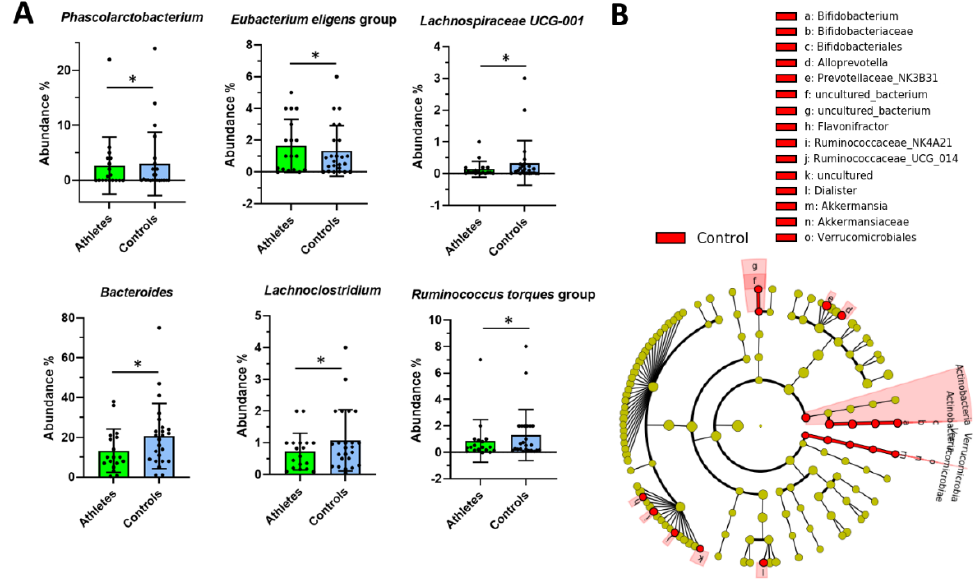
Figure 3. ( A ) The differential genus level abundances of the gut microbiota in the athletes ( n = 18) and controls ( n = 24). ANOVA-like comparison p values * < 0.05. ( B ) Cladogram from the LEfSe-analysis. The gut microbiota taxa that are highlighted were found to be enriched in the control